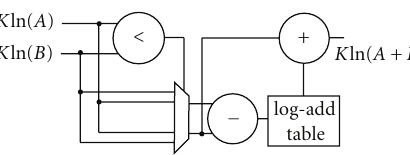
Figure 7: Log-add algorithm for